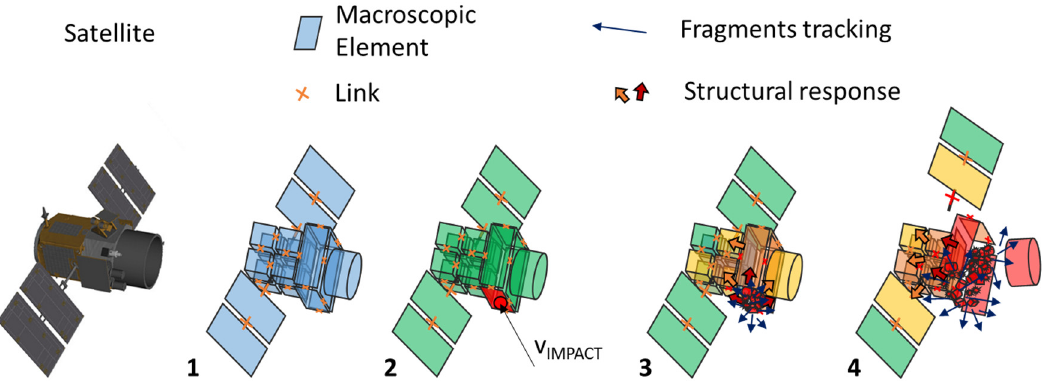
Figure 12. CSTS logic: the spacecraft is modelled as a net of macroscopic element connected by structural links ( 1 ); during impact ( 2 ), the collided ME fragments ( 3 ), and the start of a cascade effect structural links (1); during impact (2), the collided ME fragments (3), and the start of a cascade effect involving the other MEs ( 4 involving the other MEs (4).